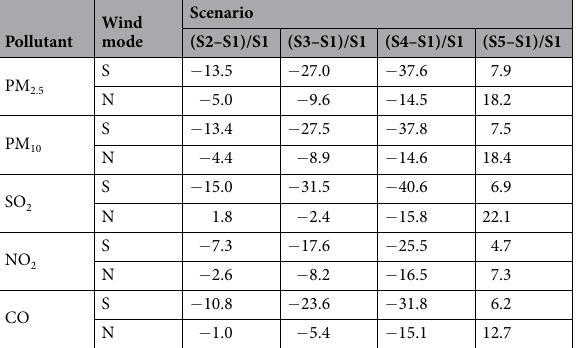
Table 3. Percentage changes (%) in the pollutant concentrations among the different scenarios and the different wind modes.